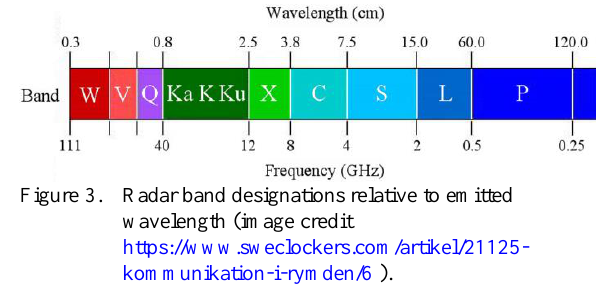
Figure 3. Radar band designations relative to emitted wavelength (image credit